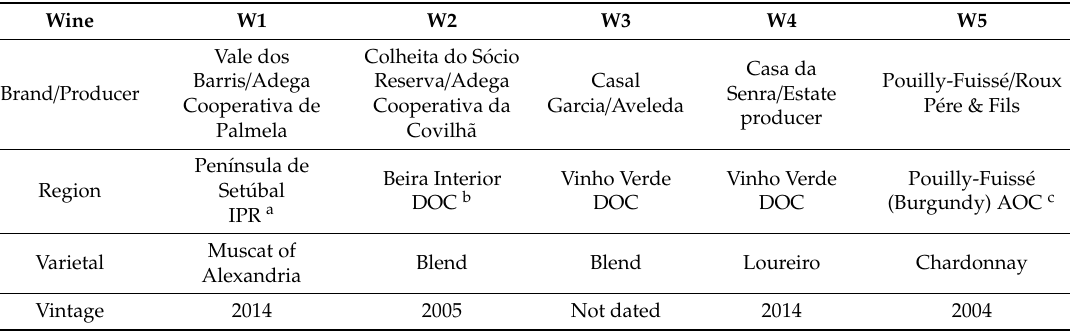
Table 1. Summary description of the Portuguese white wines used in the Optimized Descriptive Profile (ODP), Check-All-That-Apply (CATA) test, and in the consumer tasting. Wine W1 W2